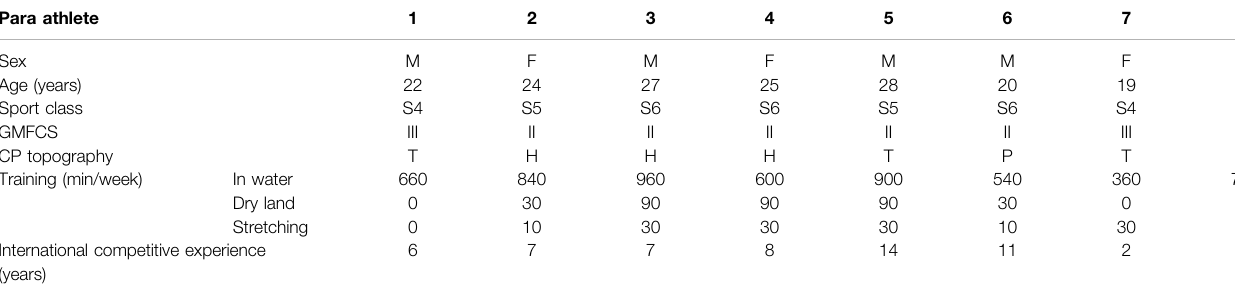
TABLE 2 | Demographic, disease-related, and athletic characteristics of the 8 subjects included in the study. The pre fi x “ S ” corresponds to freestyle. There are ten sport classes for this style (1-10). Para swimmers with greater physical limitations compete in lower classes. Abbreviations: GMFCS, Gross Motor Function Classi fi